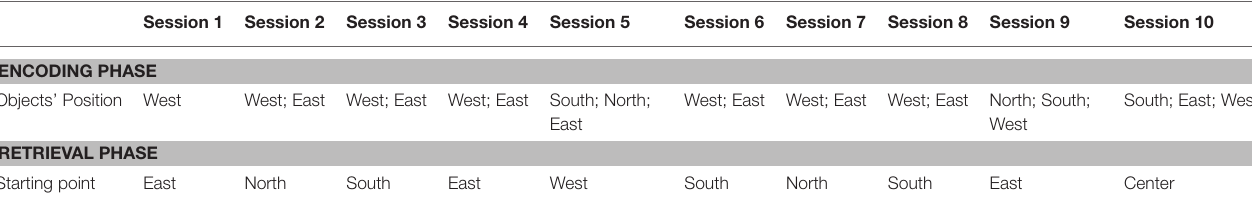
After the fifth session, the number of possible objects to be memorized remains fixed to two for three sessions (which means that there was not an increase of difficulty) because of the absence of the facilitation offered by the interactive aerial view during the retrieval phase.